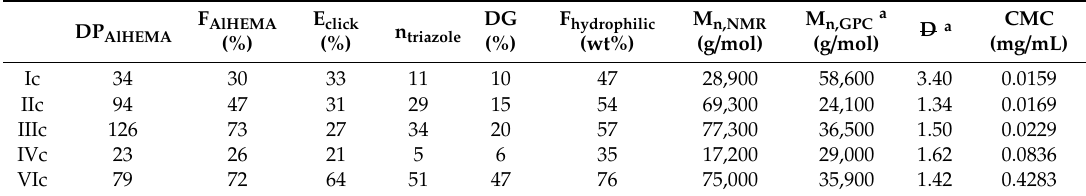
Table 2. Data for the synthesis of graft copolymers P((HEMA- graft -PEG)- co -MMA).